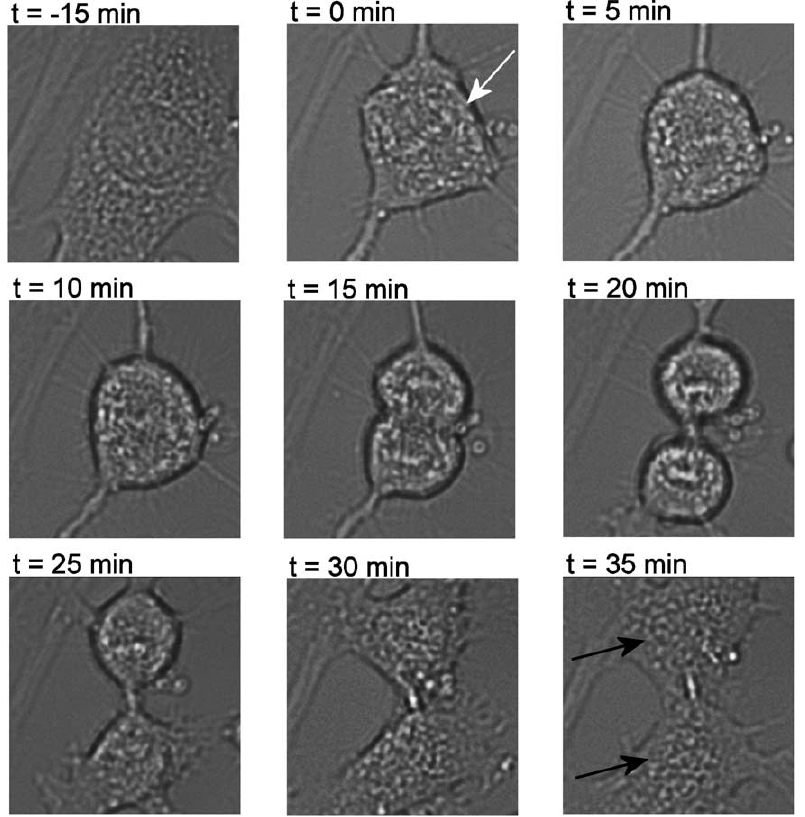
Fig. 1. Cytokinesis of unmodified primary human fibroblast. Representative time lapse images showing cell division of a BRCA2 + / − unmodified primary human fibroblast. The cell division starts when chromosomes become visible and line up in an equatorial plane of the dividing cell ( t = 0 min indicated by white arrow) and continues until the cytoplasm of the daughter cells has separated (black arrows indicate the end point). Cytokinesis is in this case completed in 35 min. Images were captured by time lapse live-cell imaging with a 40 × objective and bright field light every 5